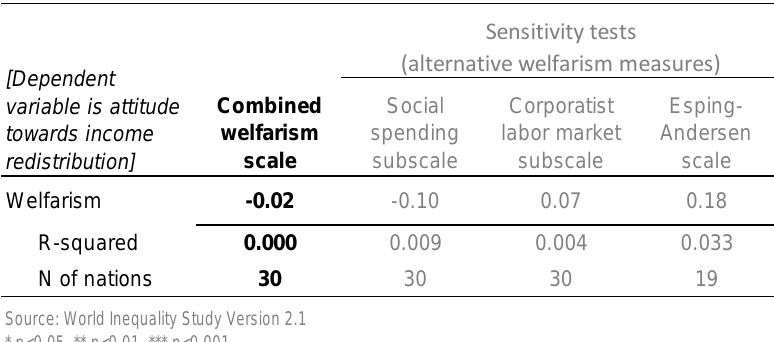
Figure 12. How much redistribution ought we have? Country means and OLS fit lines (welfarism: solid red; Esping-Andersen: dashed green).